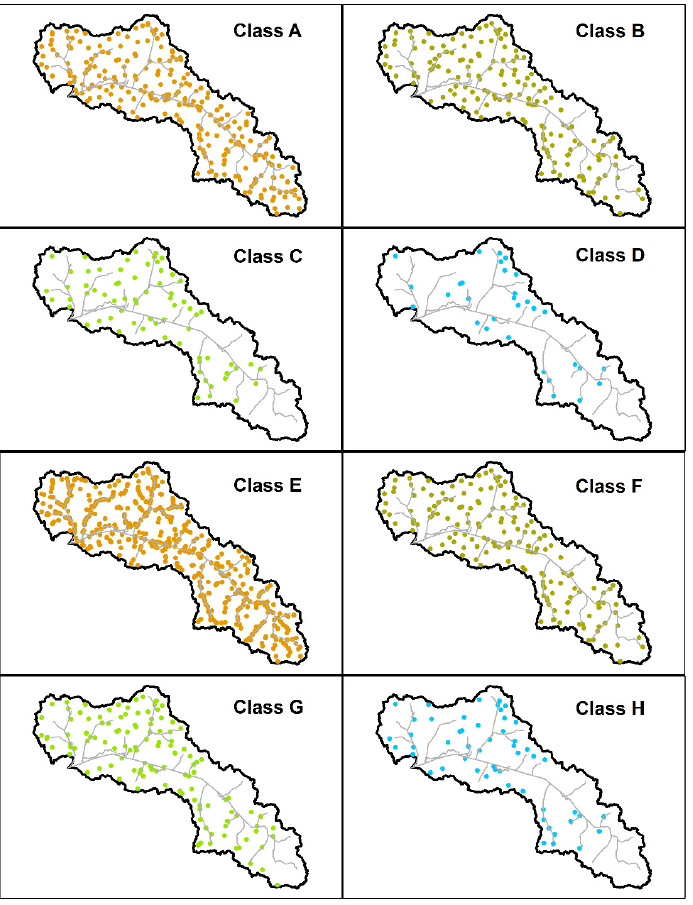
Figure 8. Proposed sediment basin locations corresponding to 8 scenarios (i.e., ( A – H ) described in Section 2.6.2). Section